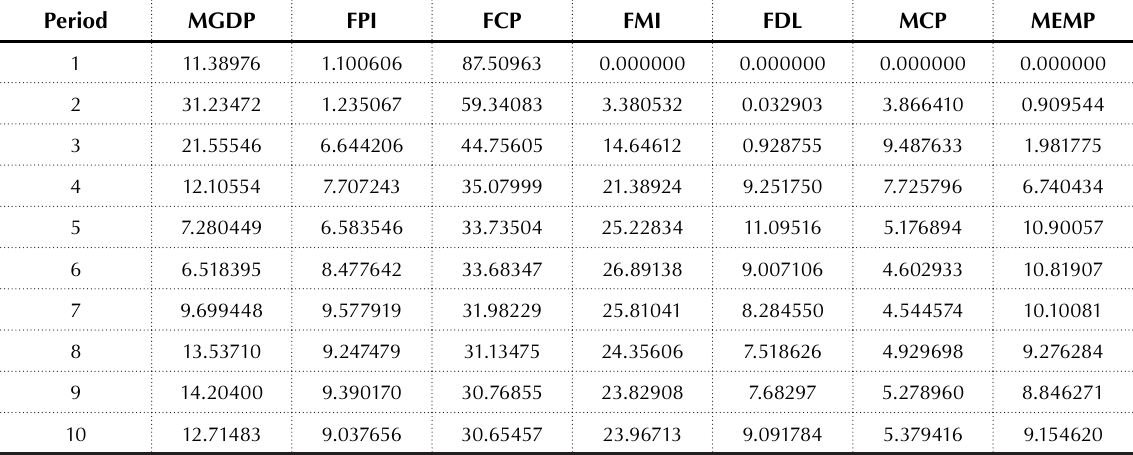
Table 4. Variance decomposition of FCP